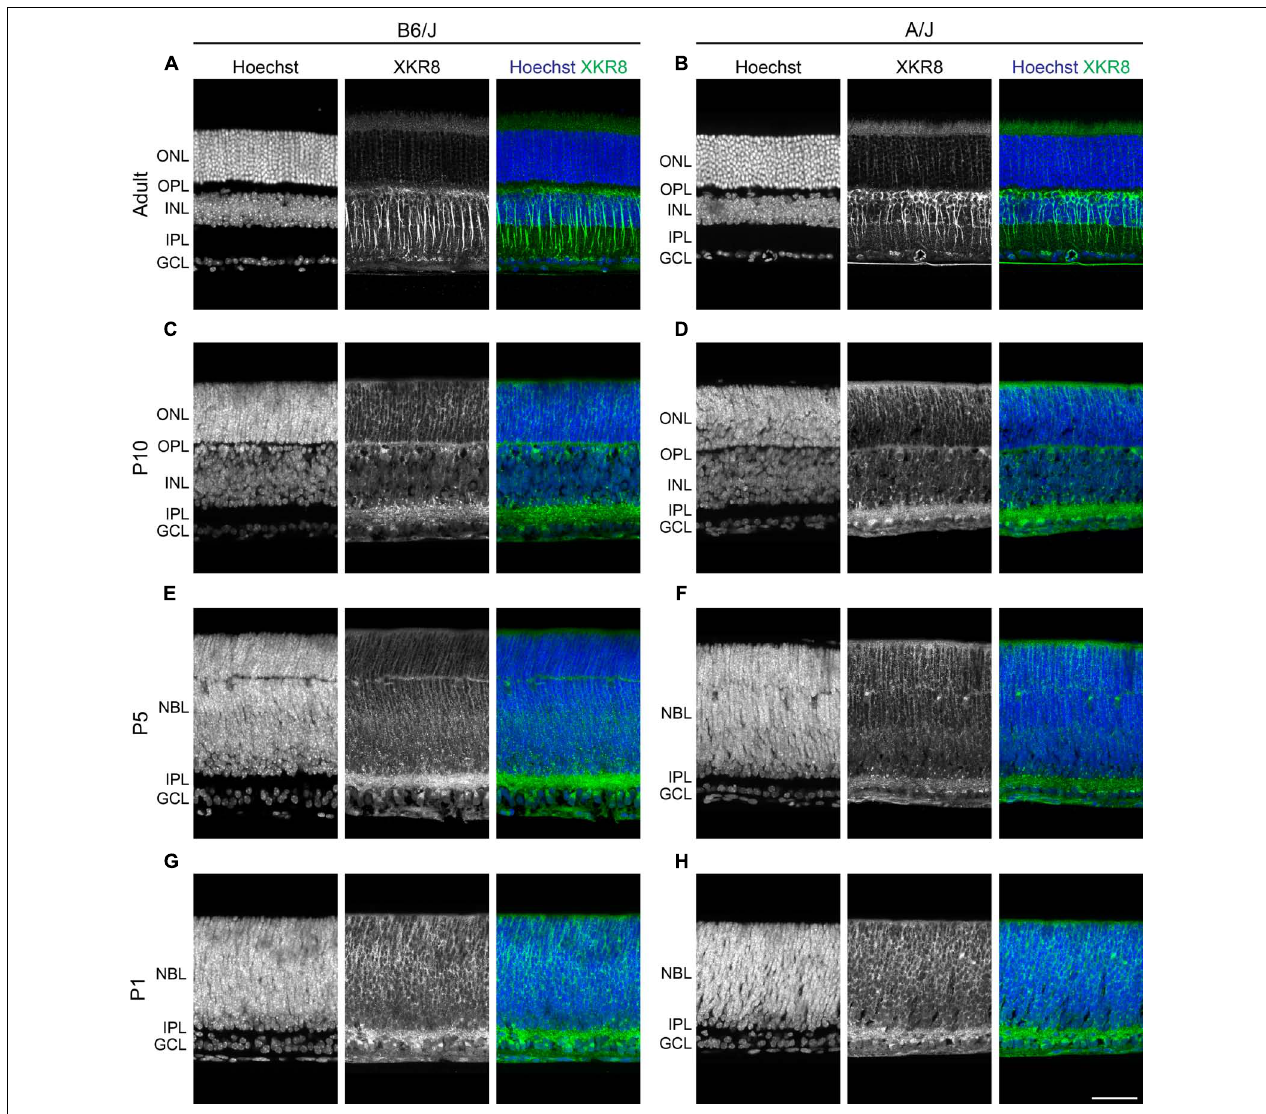
FIGURE 4 | (A,B) Strain comparison of XKR8 immunofluorescence in the mature retina, showing a comparable pattern of bipolar cell labeling in B6/J (left) and A/J (right) retinal sections. (C,D) At P10, labeling of newly differentiating bipolar cells was detected, as well as labeling in the ONL and amongst amacrine and